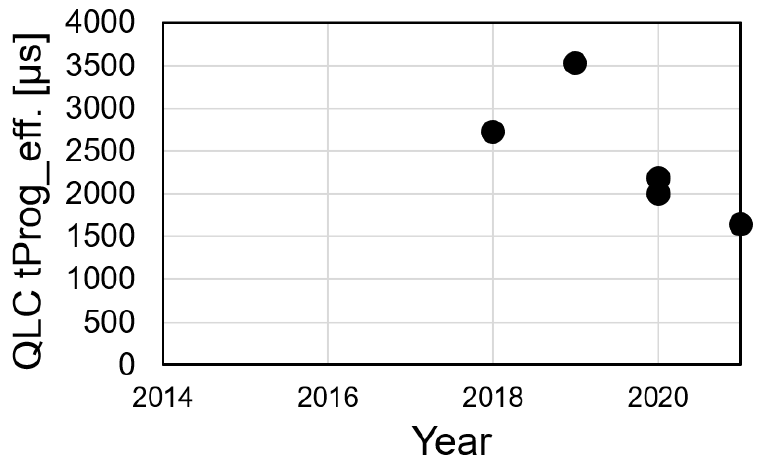
Figure 21. QLC effective tProg reported or calculated from ISSCC publications.